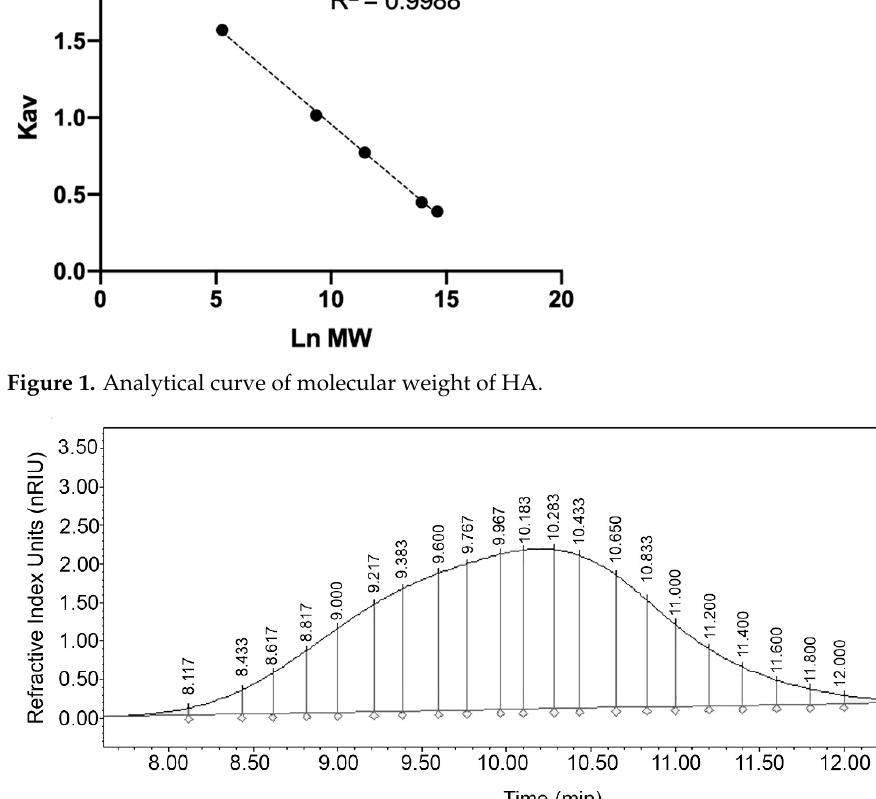
Figure 2. Integrated chromatogram with differential molecular weight distribution of HA sample at optimal conditions.